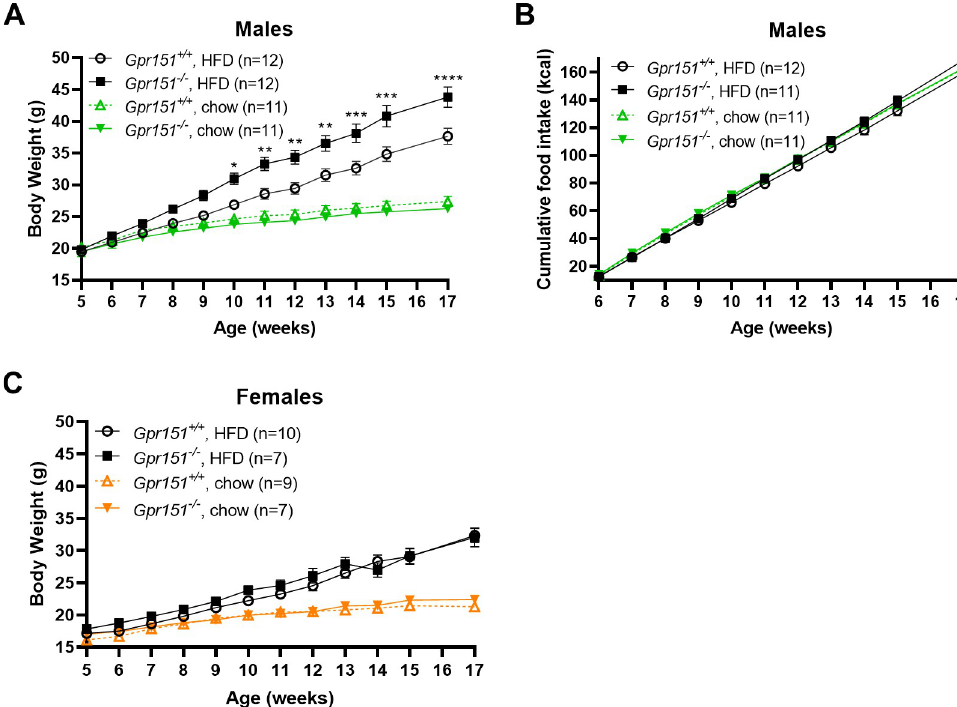
Fig 3. Male Gpr151 -/- mice gain weight on high-fat diet (HFD). (A) Body weights of male Gpr151 +/+ and Gpr151 -/- mice on a standard chow diet (chow) and high-fat diet (HFD). Data are presented as ± standard error of the mean (SEM). � p < 0.05, �� p < 0.01, ��� p < 0.001, ���� p < 0.0001, repeated measures, two-way ANOVA followed by post-hoc analysis using Sidak’s multiple comparisons test. (B) Cumulative food intake in kcal (kilocalories) of male Gpr151 +/+ and Gpr151 -/- mice on a standard chow diet and high-fat diet. Data are presented as ± SEM. (C) Body weights of female Gpr151 +/+ and Gpr151 -/- mice on a standard chow diet and high-fat diet. Data are presented as ± SEM.